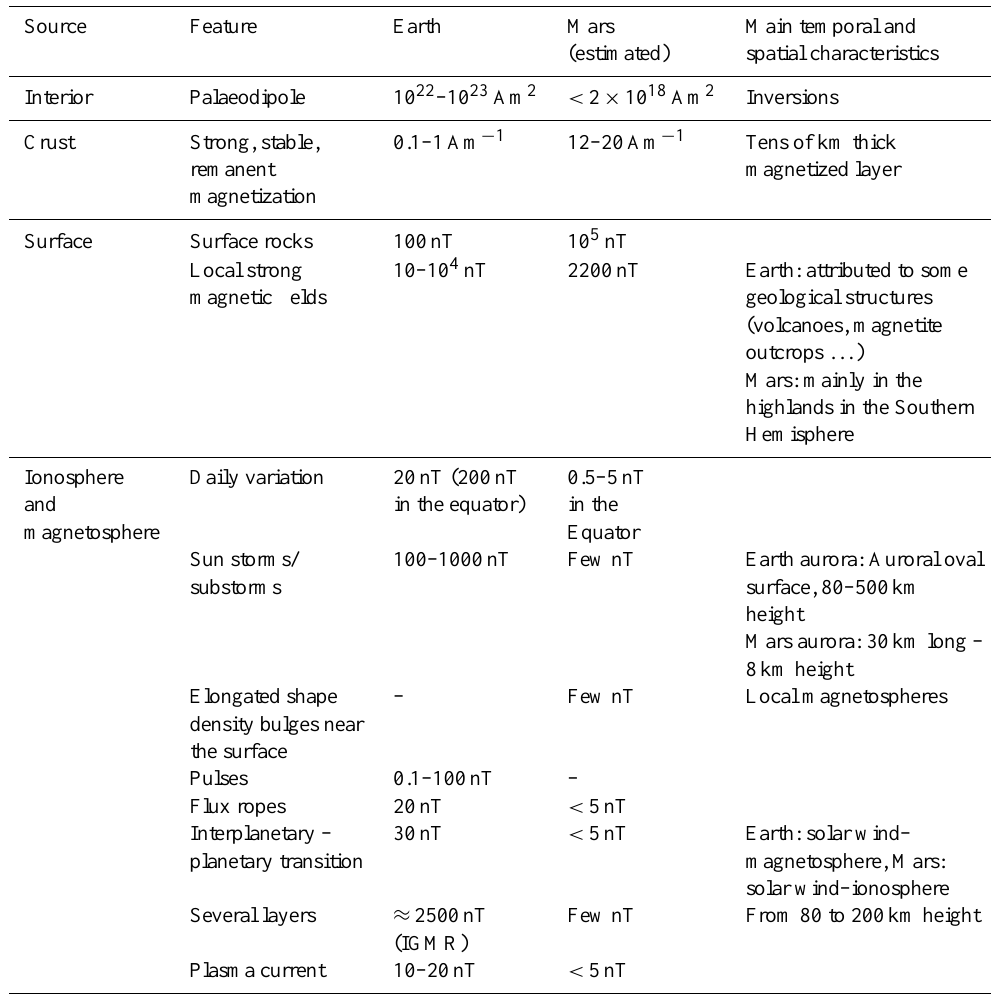
Table 1. Main field intensities of the magnetic sources on Earth and